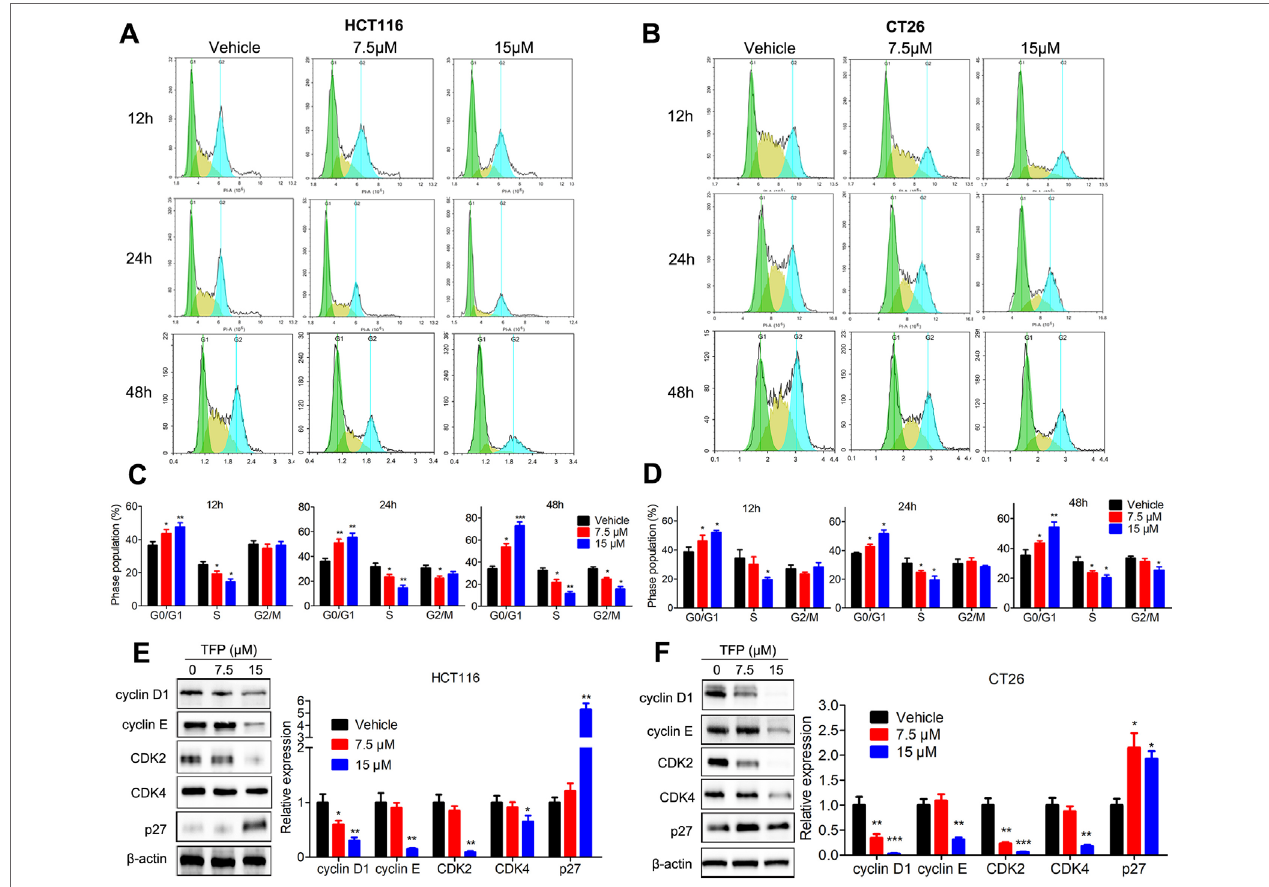
FIGURE 3 | TFP induced G0/G1 arrest in HCT116 and CT26 cells. (A and B) HCT116 (A) and CT26 (B) cells were exposed to TFP for 12, 24, or 48 h and then stained with PI. Cell cycle distributions were analyzed by FCM. (C and D) Quantification of cell cycle distribution after TFP treatment in HCT116 (C) and CT26 (D) cells. (E and F) Expression levels of proteins involved in G0/G1 regulation were determined by western blot in HCT116 (E) and CT26 (F) cells after 48 h of TFP treatment. Quantification of the protein expression levels is shown to the right of each cell line. *P < 0.05, **P < 0.01, ***P <